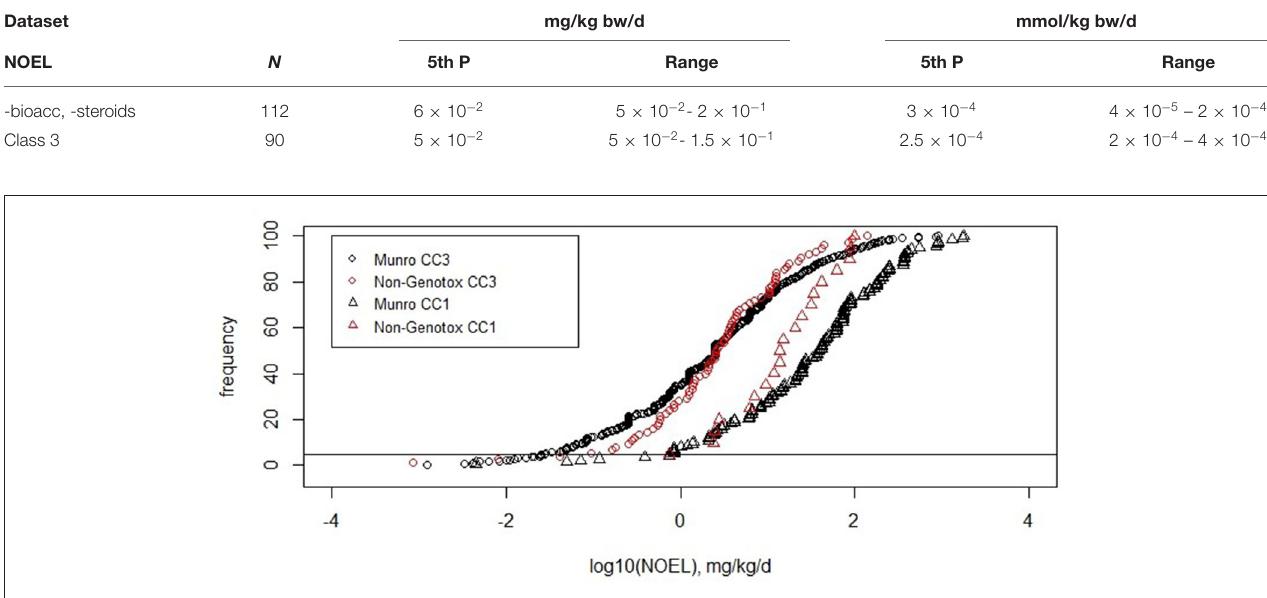
FIGURE 4 | Cumulative frequencies of the original Munro data and non-genotoxic dataset for Cramer classes 1 and 3.